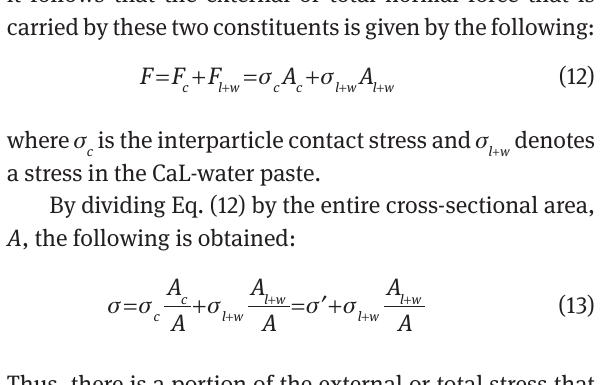
Equation (11) shows that water content, gravimetric lignin content, and void ratio affect the normalized area ratio. The latter is a ratio of the cross-sectional areas occupied by CaL and water paste and a total cross-sectional area, which is further divided by gravimetric lignin content.